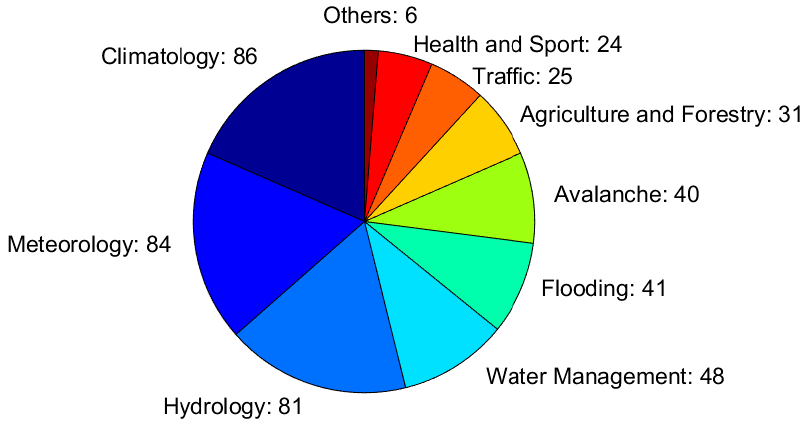
Figure 3. Application areas of the snow measurements, and the number of respondents selecting them. The width of each slice corresponds to the fraction each application area has, relative to the total number of the application areas reported (i.e., the sum of the numbers given in the figure). Figure 4 illustrates the occurrence of measurement sites typologies. As in the case of the application areas, the respondents could select more than one of the listed site typologies and respondent/institution may perform measurements in different site types, and because a single site may belong to more than one typology (e.g., a forest covered mountain site could have been classified